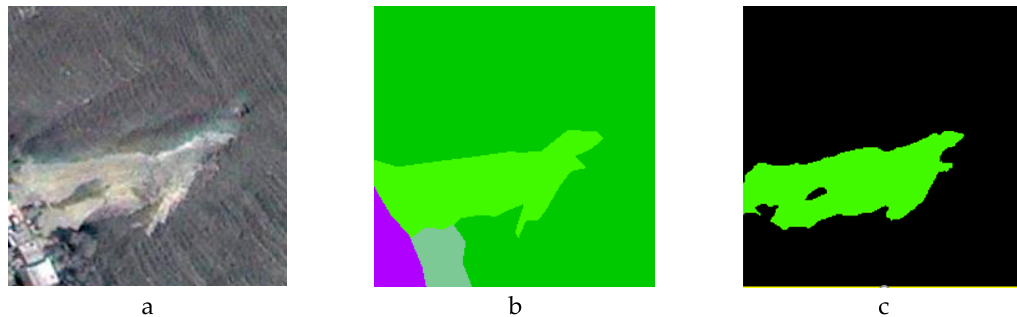
Figure 5. ( a ) Remote sensing sample; ( b ) object-based GT for training the network; ( c ) object mask (landslide) from our semantic segmentation network.